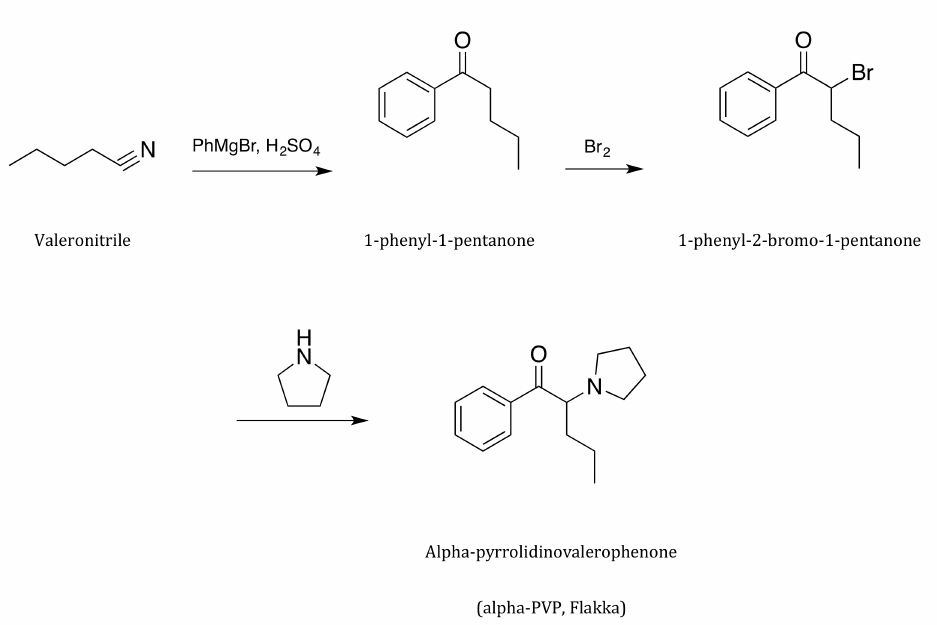
Figure 2. Flakka ( α -pyrrolidinovalerophenone, α -PVP)